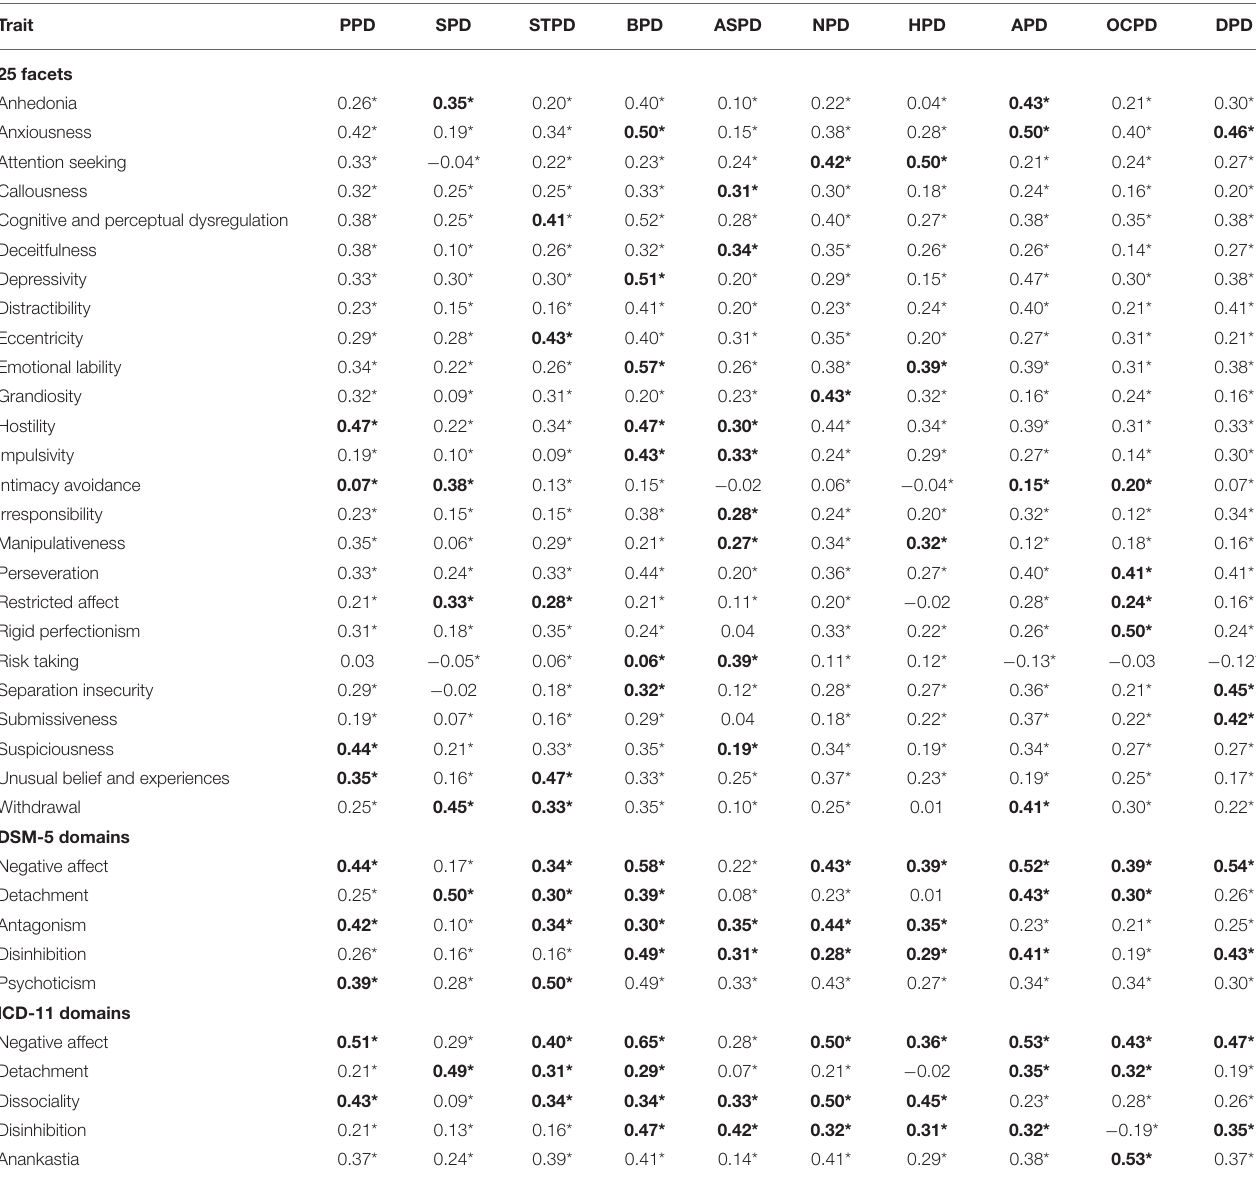
TABLE 5 | Correlation between pathological personality traits measured by the PID-5 and personality disorders measured by PDQ-4 + in the undergraduate sample.